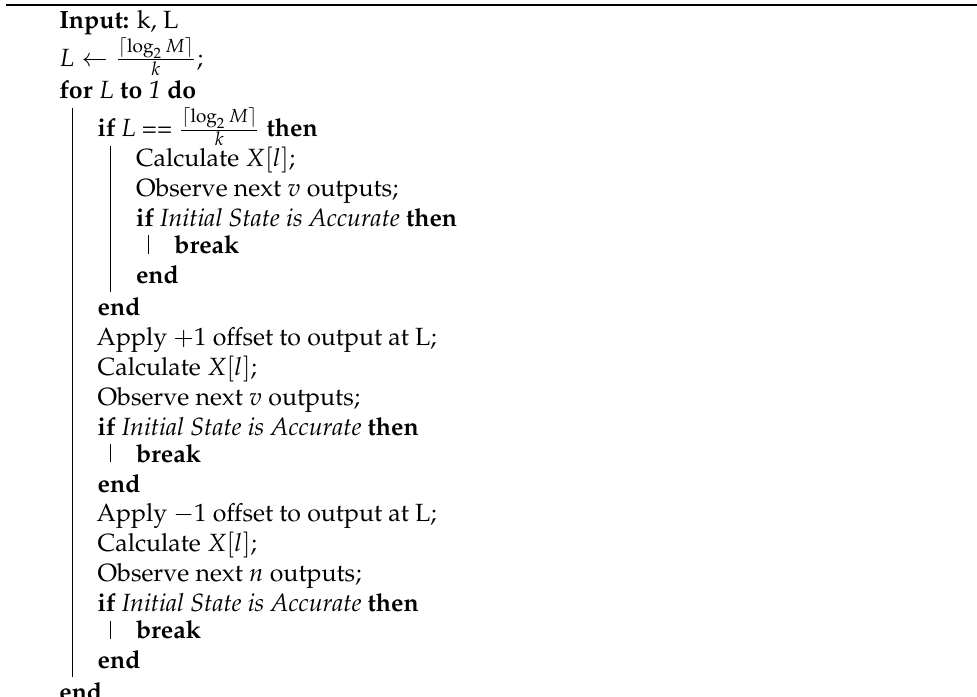
Algorithm 1: Modified RNS Attack for a Single